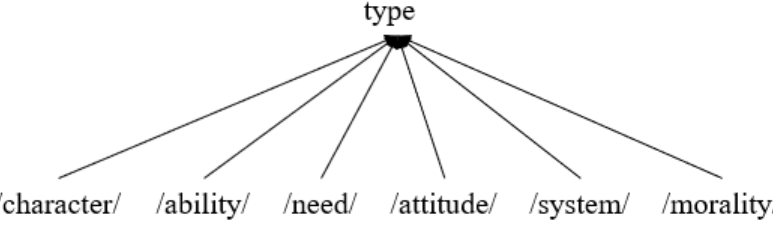
Figure 2. The essential characteristics of type analysis axis.